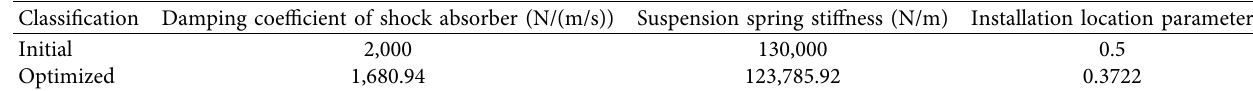
Figure 19: Plot of f Table 3: Suspension parameters before and after optimization.